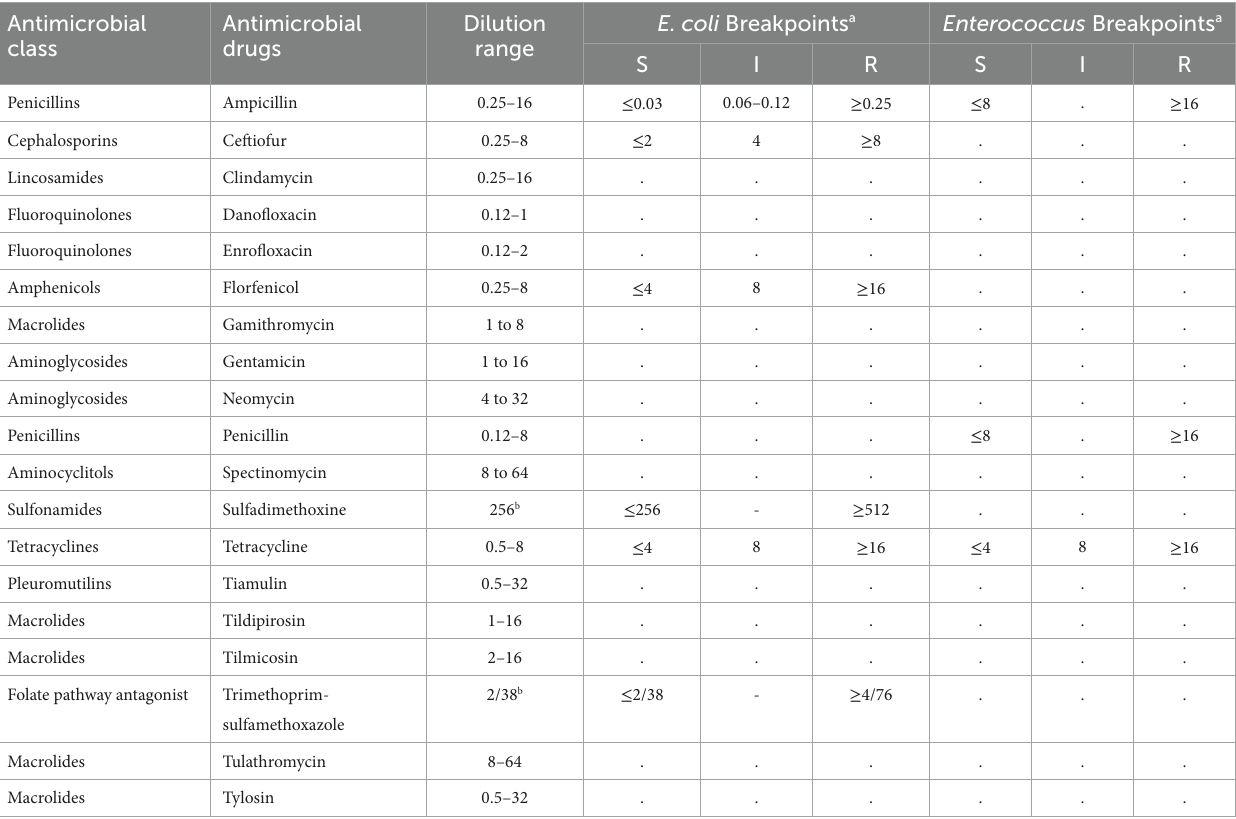
TABLE 1 Antimicrobials included in the BOPO7F vet antimicrobial susceptibility testing plate, dilution ranges, and breakpoints used for evaluation of 244 Escherichia coli and 238 Enterococcus isolates (μg/mL). The data was used to interpret the antimicrobial susceptibility test results and estimate the prevalence of antimicrobial resistant E. coli and Enterococcus in fecal samples from cow-calf operations in northern California collected between July 2019 and August 2022. Antimicrobial